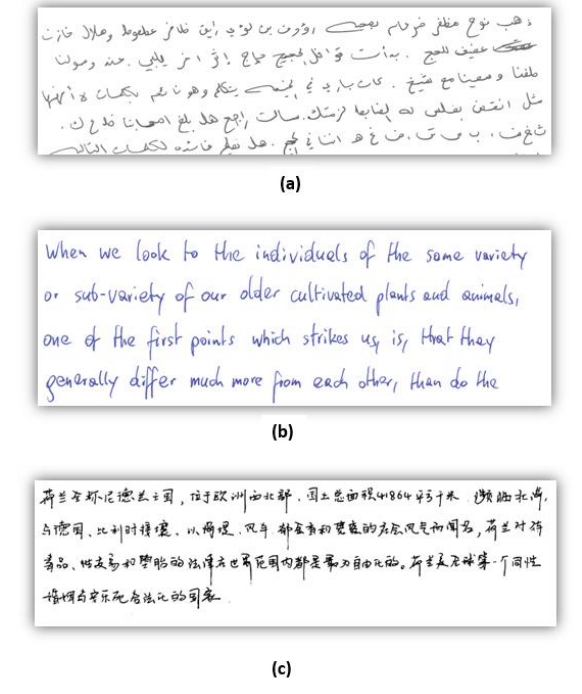
Figure 1 . Handwriting samples from (a) KHATT, (b) CVL